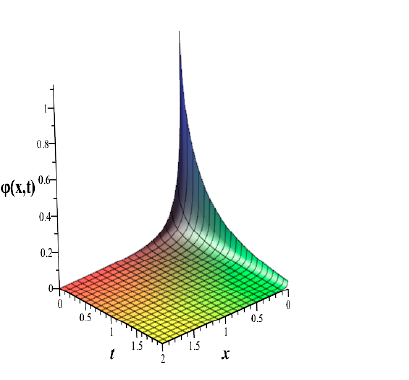
ϕ of Equation (55) for the para- = t and 1,8.0,5.0